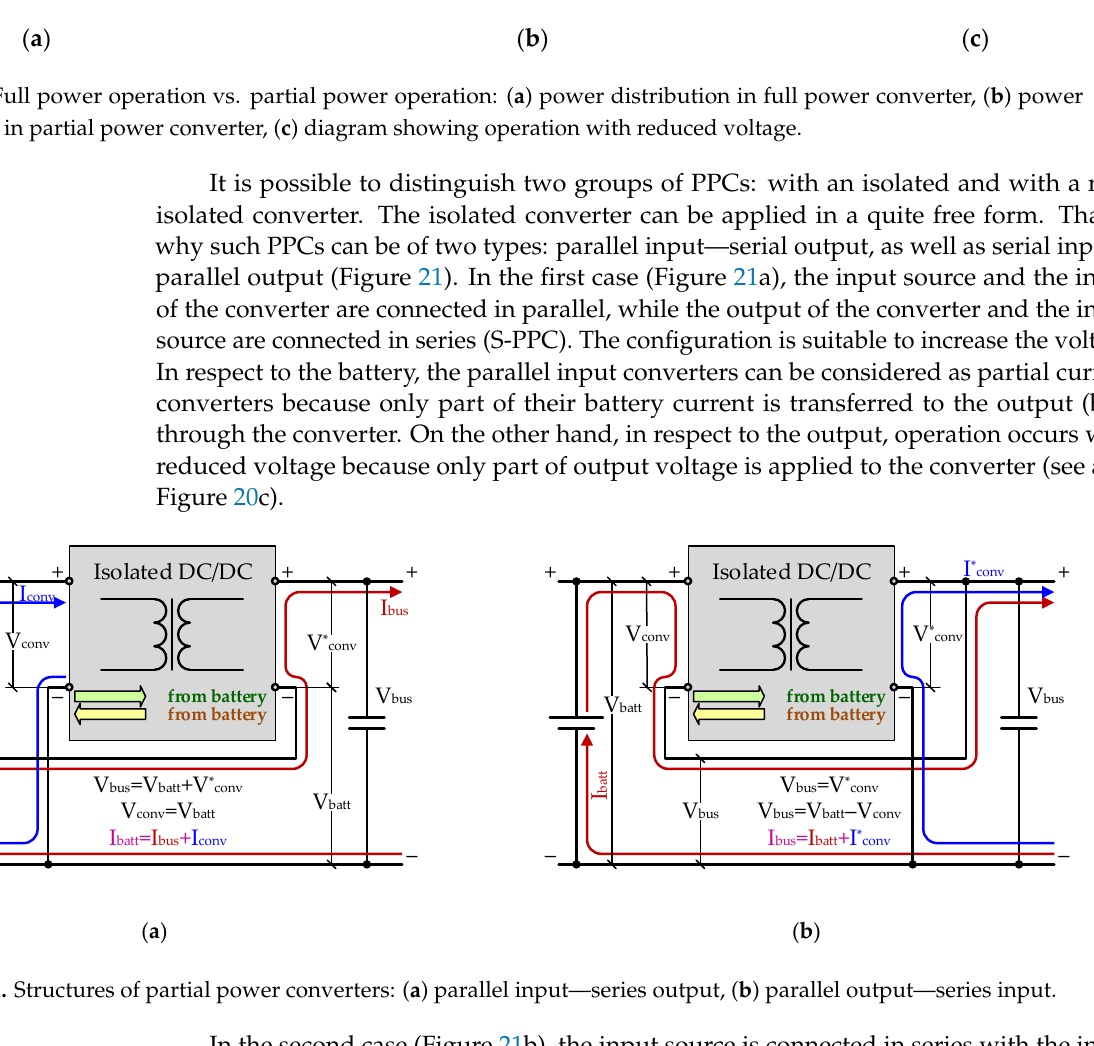
Figure 21. Structures of partial power converters: ( a ) parallel input—series output, ( b ) parallel output—series input.